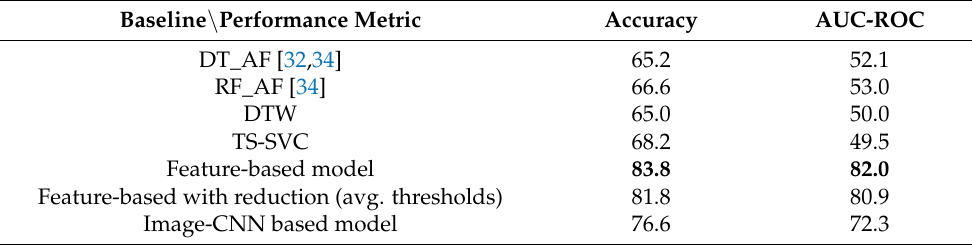
Table 4. Performance comparison against